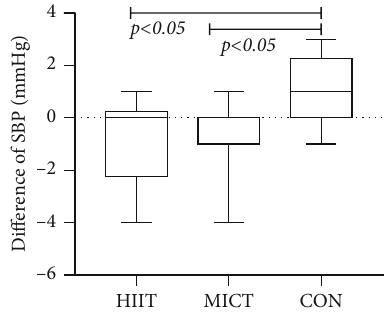
Figure 9: Blood pressure di ff erences of each group after intervention.